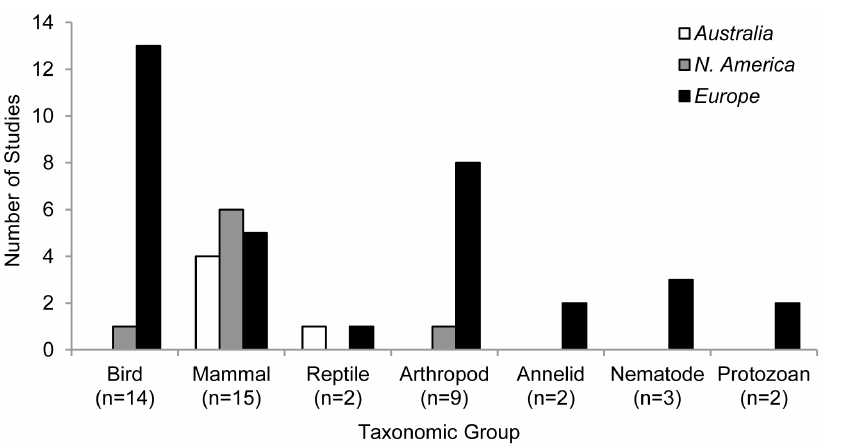
Figure 4. Number of studies (n=41) investigating the impacts of winter recreation on different taxa across three continents. Four studies investigated multiple taxa, hence totals for taxonomic groups do not sum to the total number of studies analysed.